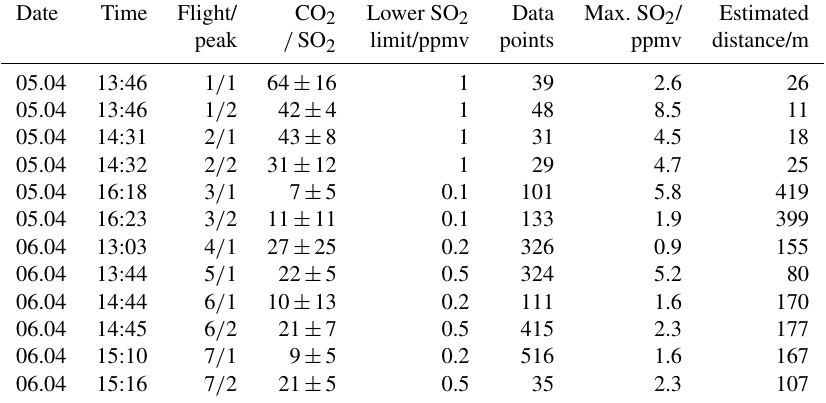
Table 2. Overview of the retrieved CO 2 / SO 2 ratios with parameters for the linear fit at Stromboli volcano.